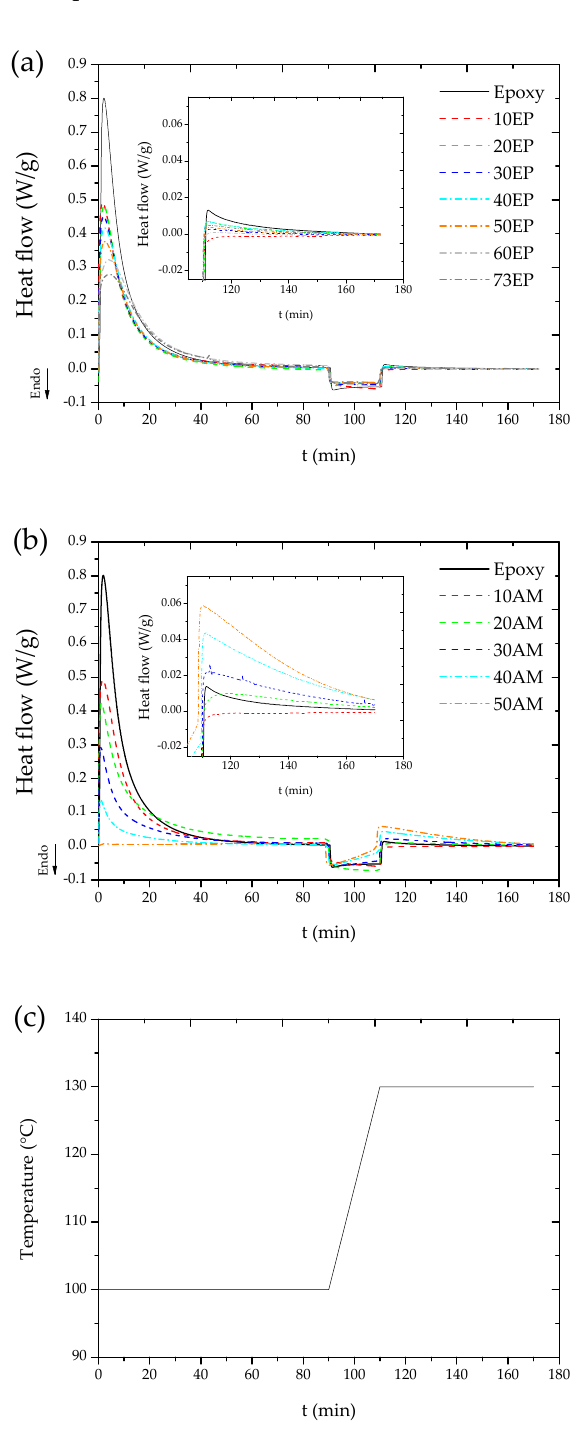
Figure 1. Di ff erential scanning calorimetry (DSC) thermograms of ( a ) epoxide (EP)–EPOSS, ( b ) amine (AM)–EPOSS samples, and ( c ) temperature profiles of the curing (100 ◦ C for 1.5 h) and post-curing (130 ◦ C for 1 h)